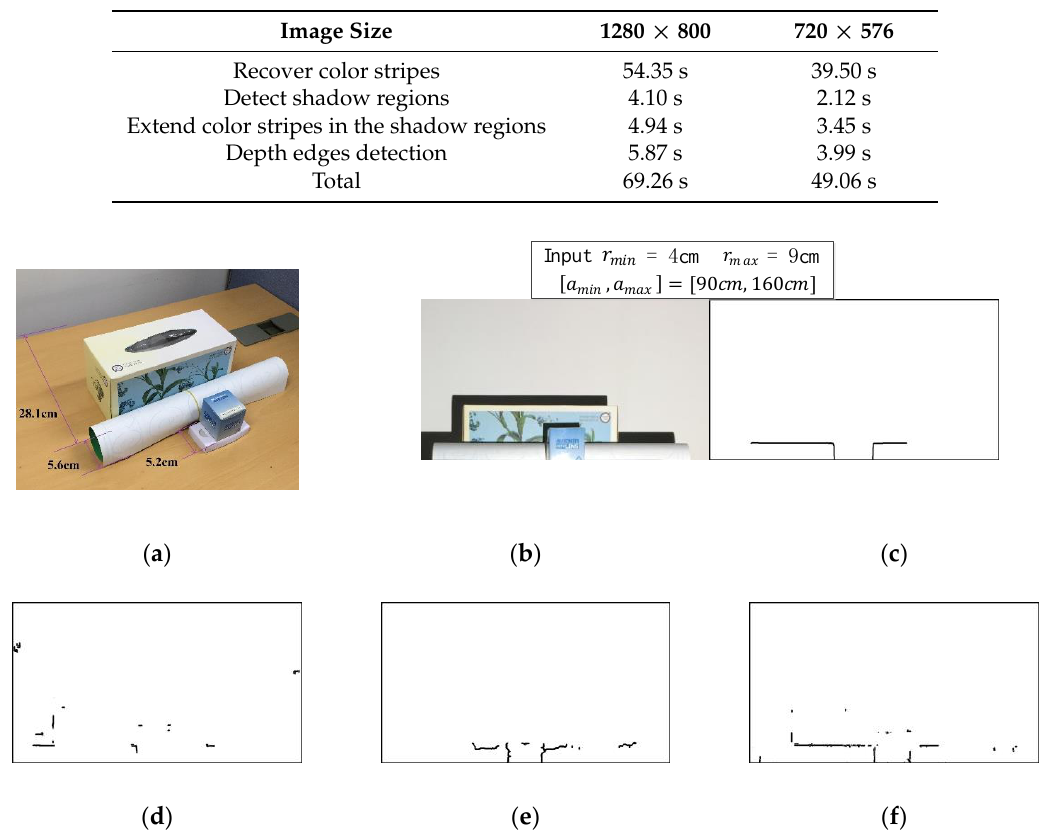
Figure 13. Depth band-pass filtering results for 4 cm ≤ r ≤ 9 cm: ( a ) experimental setup; ( b ) front view; ( c ) ground truth; ( d ) method in [8]; ( e ) Kinect; ( f ) our method.